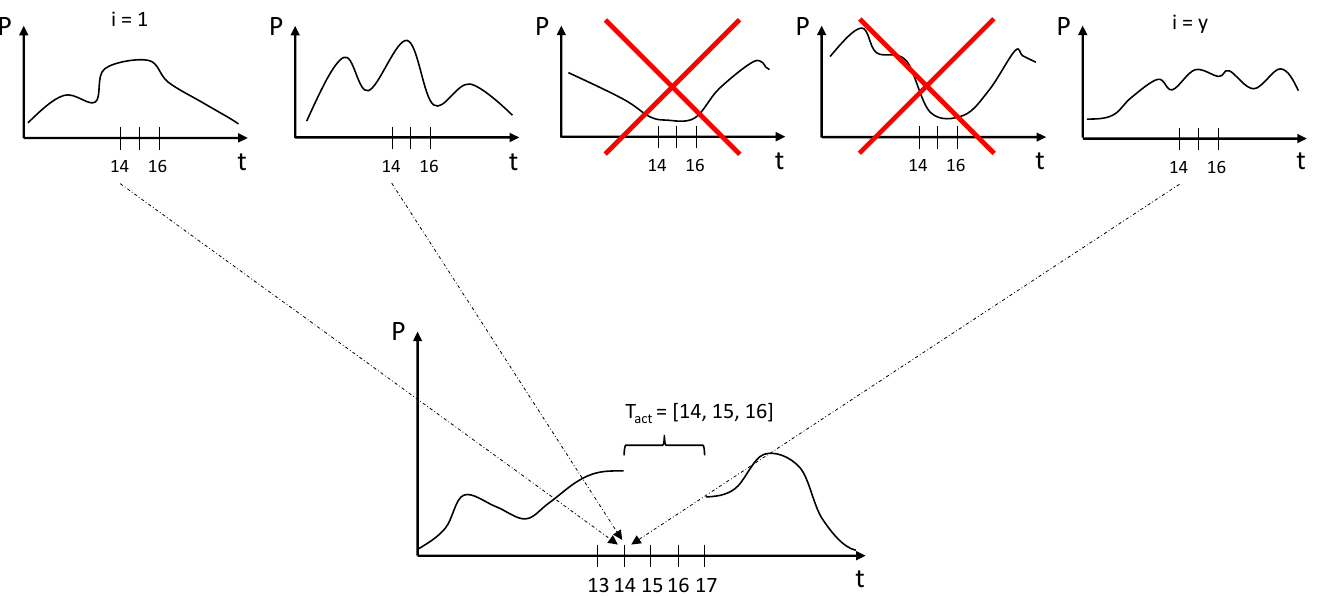
Figure 5. Illustration of baseline III and its variables. The necessary data is taken per timestep, for the previous y days. As only x out of y historical days are included, not all historical values are